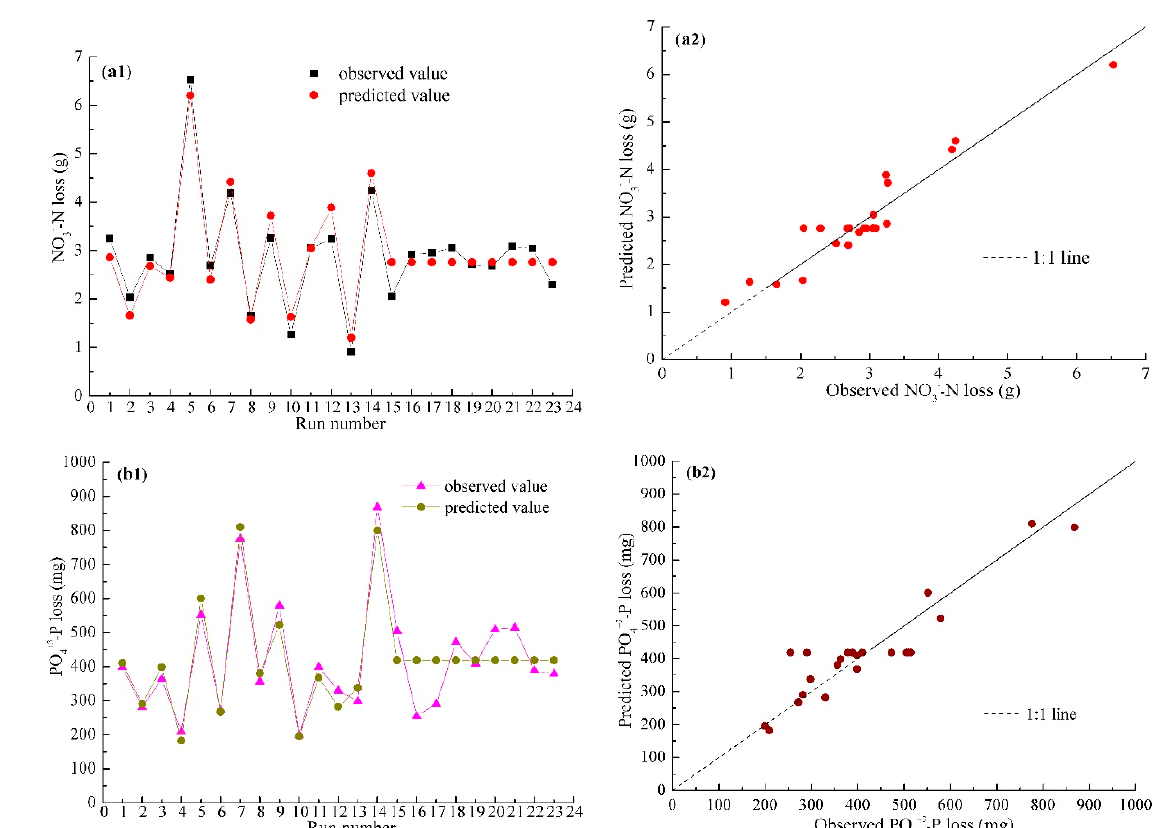
Figure 5. The curve and plot of the observed and predicted NO 3 − –N ( a1 , a2 ) and PO 4+3 –P loss ( b1 , b2 ). Table 3. The regression coefficient significance test for the second-order polynomial. Regression